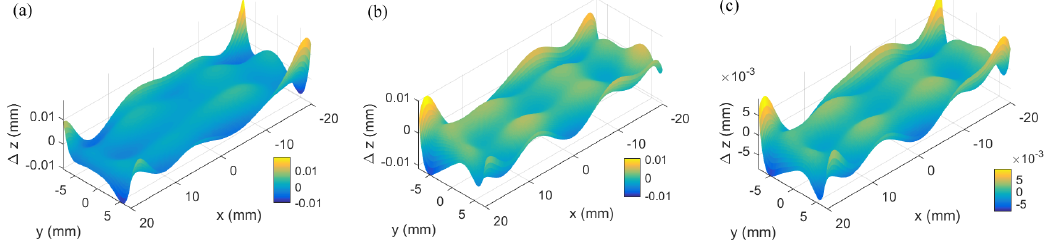
Figure 13. Deviation from the underlying surface from the results of: ( a ) Sensor 1; ( b ) Sensor 2; and ( c ) fused data. Table 2. RMS (root mean squared) value of associated uncertainties of the original measurement datasets and fused dataset.